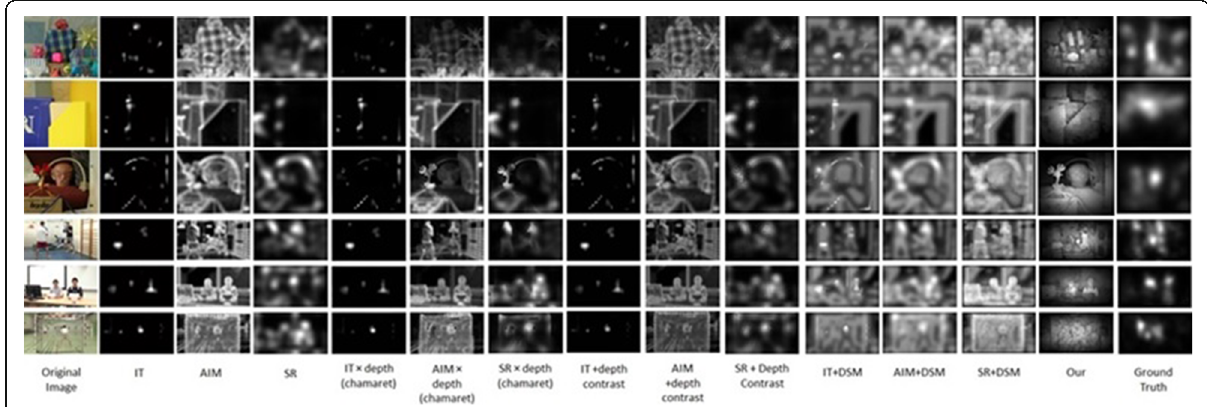
Fig. 9 Stereo comfort zone based on human stereo vision. DSM represents the depth saliency map in